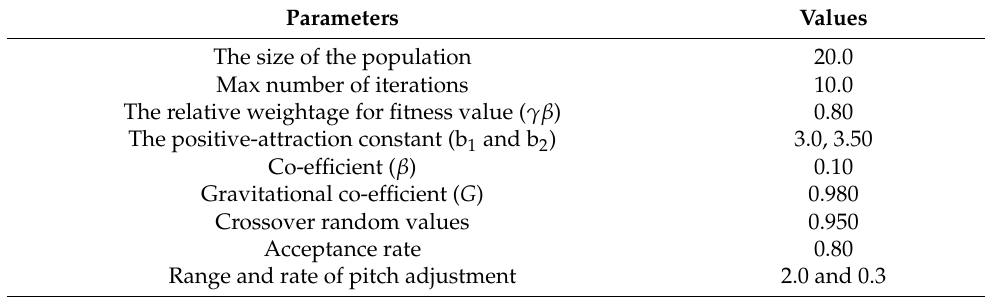
Table 2. MA parameters.